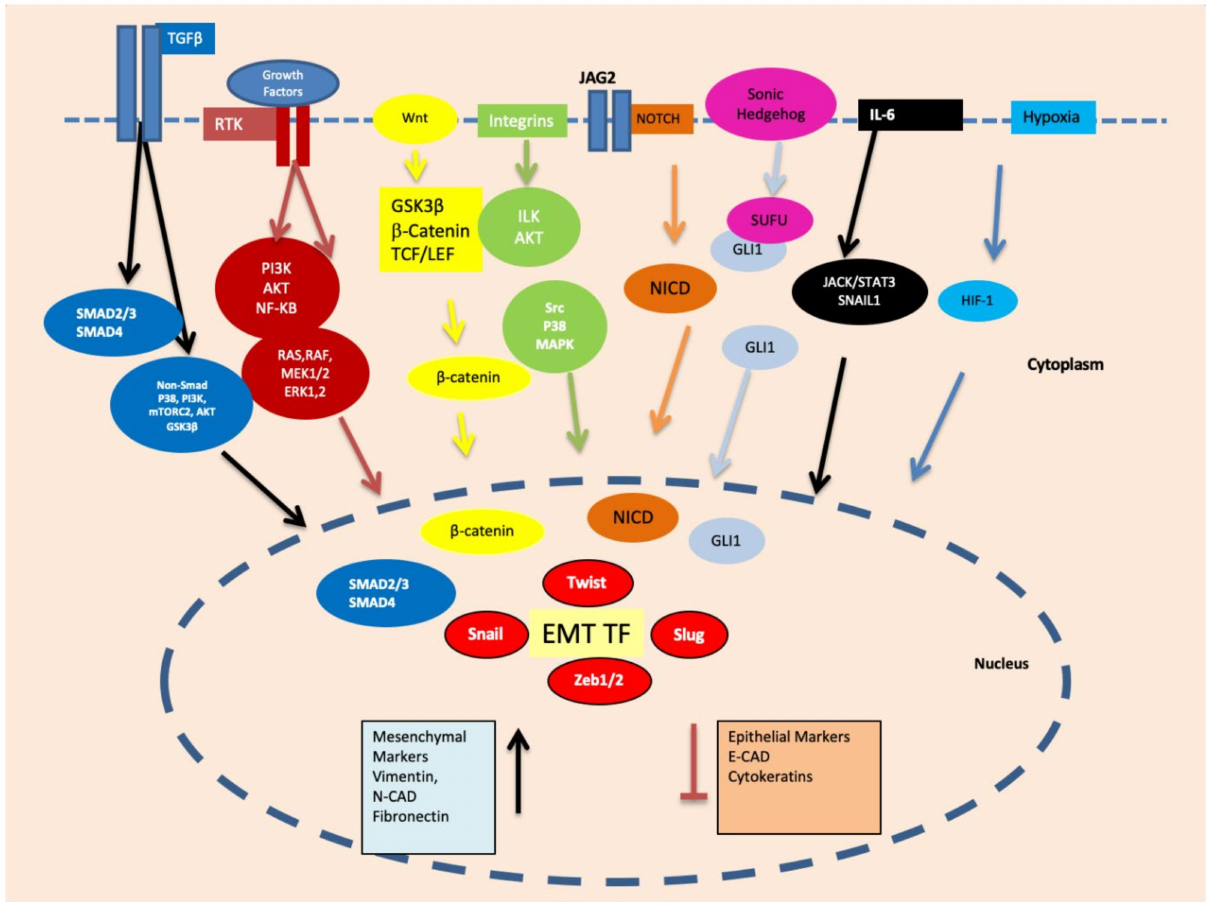
Figure 2. Important signalling pathways, such as Smad, PI3K/mTORC2/AKT/GSK3 β , RAS/RAF/MEK1/2/ERK1, PI3K/AKT/NF- κ B, ILK/AKT, Src/P38/MAPK, NOTCH, GLI1/SNAI2, JACK/STAT3 and HIF-1 are activated during EMT via growth factors, hypoxia and other microenvironmental factors. These signalling pathways ultimately upregulate the transcription factors related to EMT such as Snail, Slug, Twist, ZEB1 and